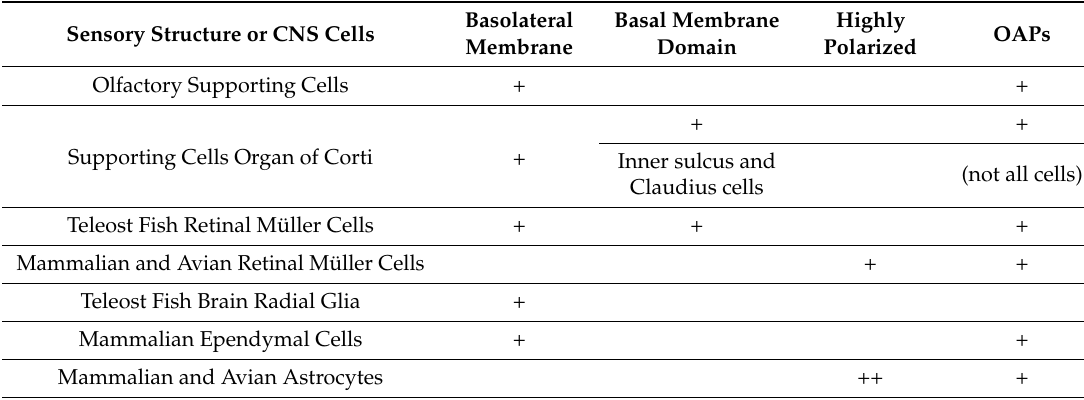
Table 1. Cellular membrane distribution of